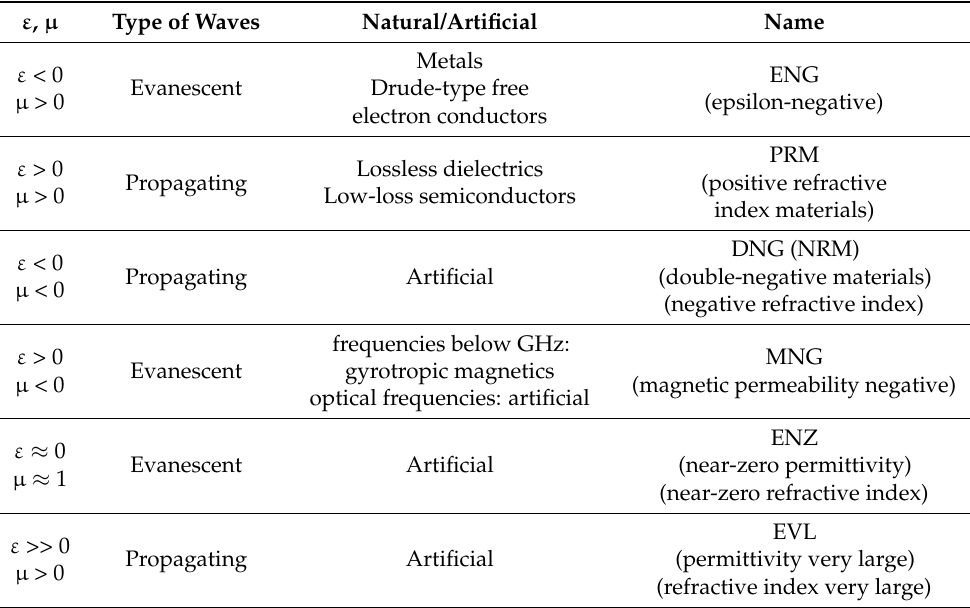
Table 2. Summary of achievable types of nanocomposites according to the values of their effective permittivity and